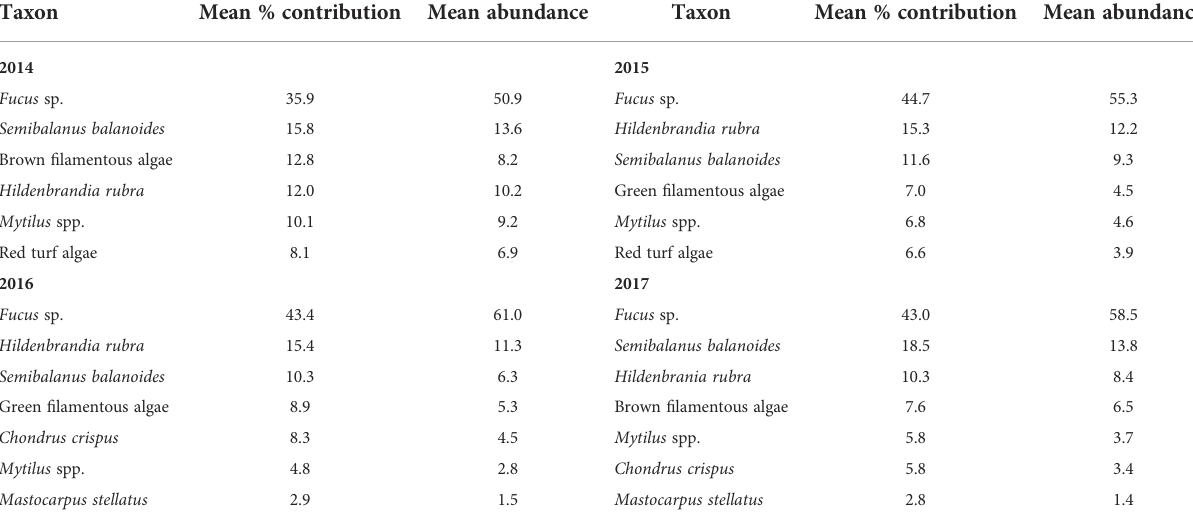
TABLE 3 Summary results of SIMPER analyses for sessile species, indicating the mean percent contribution to similarity in species composition among locations (see Materials and Methods for details) and the mean abundance (percent cover) across all locations for each surveyed year. For brevity, only the species with the highest contribution are shown (those amounting to a cumulative contribution of 90%). Taxon Mean % contribution Mean abundance Taxon Mean % contribution Mean